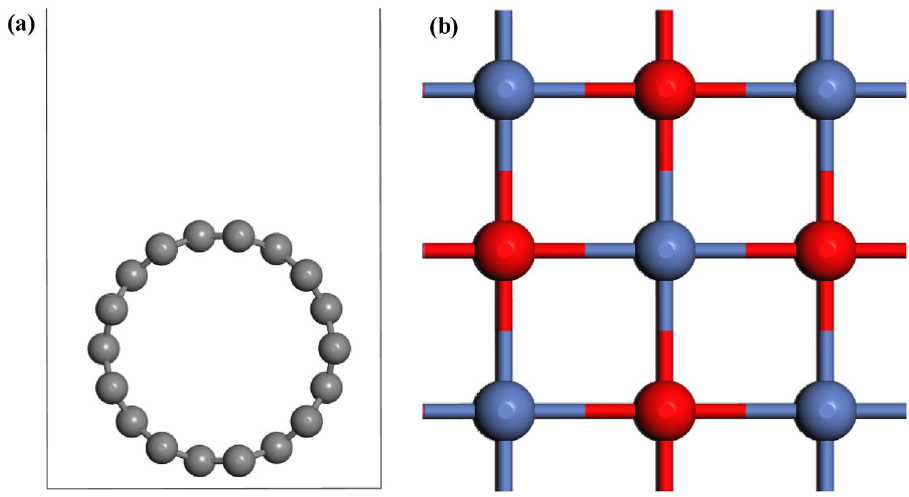
Figure 7. The optimized crystal structures of ( a ) SWCNTs and ( b )